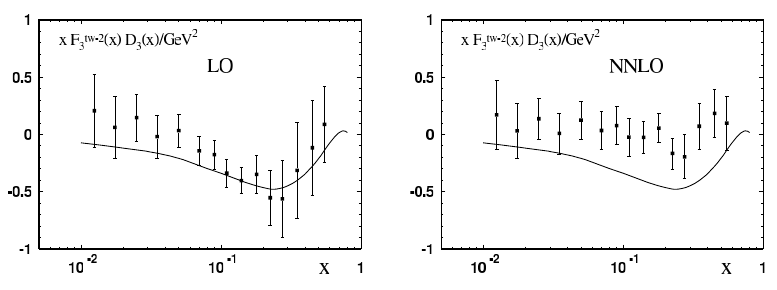
Figure 4. Twist-4 correction to xF 3 ( x , Q 2 ) as extracted from the (revised) CCFR data. The data points [46] are overlaid with the shape obtained from the “renormalon model” for the 1 / Q 2 power correction. Figure adapted from